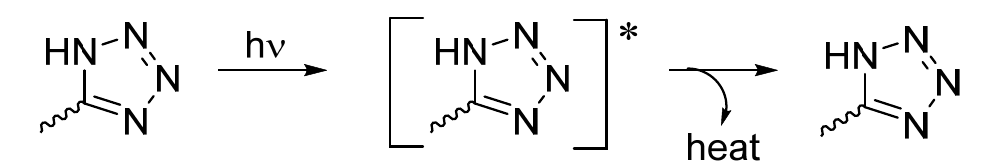
2 SnL 2 , where both improved the polymeric